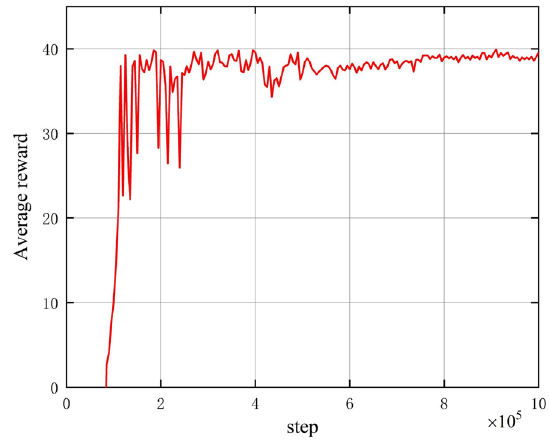
Figure 14. Convergence iteration curve during training.